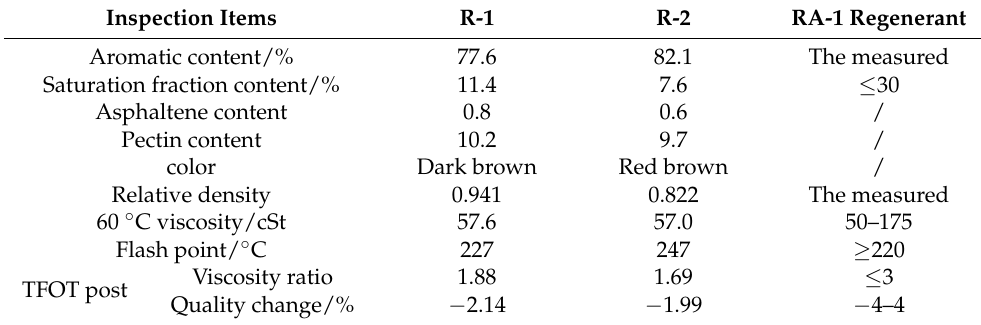
Figure 1. Comparison of the two REOB types. Table 2. Comparison of REOB basic performance.